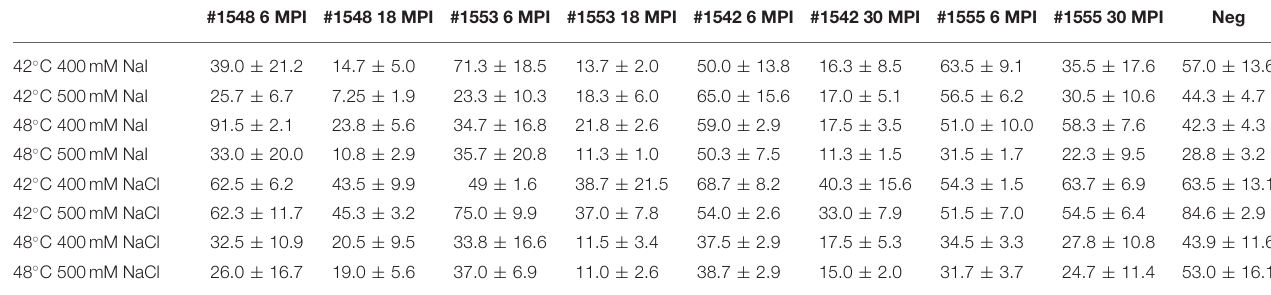
TABLE 2 | Lag time analysis from real-time quacking-induced conversion reactions seeded with preclinical fecal samples in different temperatures, different salt types, and